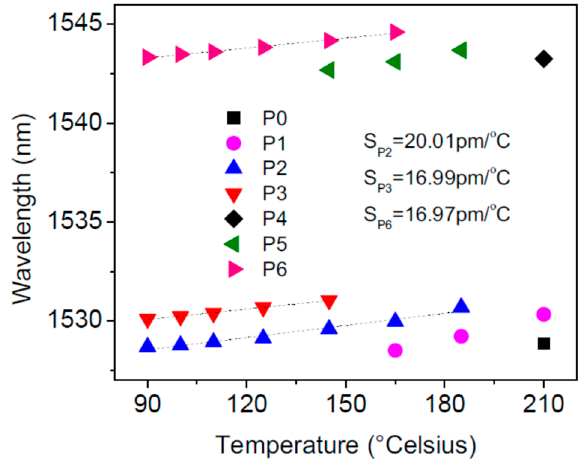
Figure 9. Temperature data analysis for peaks P0 to P6. Temperature-wavelength response for peaks P2, P3, and P6.